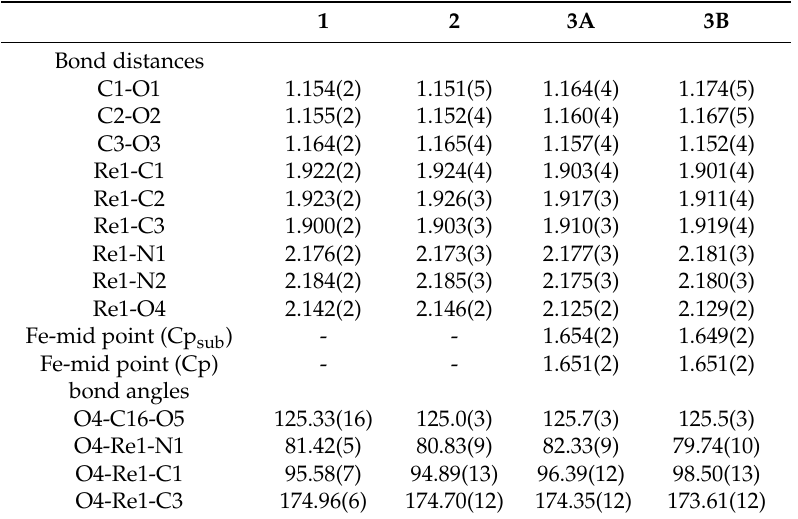
Figure 2. Oak Ridge thermal ellipsoid plot (ORTEP) diagram of 1 ( left ), 2 ( middle ) and 3 ( right ). Hydrogen atoms omitted for clarity. Displacement ellipsoids drawn at a 50% probability level. Table 1. Selected bond distances (Å) and angles (°) of 1 – 3 (Cp sub = substituted Cp ring).